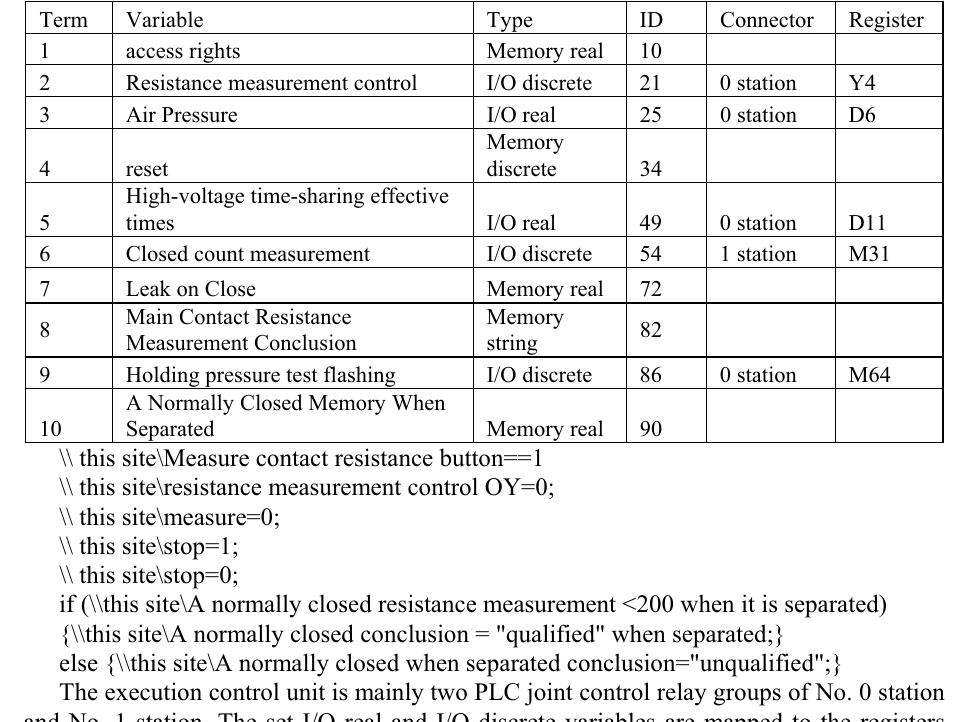
Table 1. Parts of main variable definition in communication